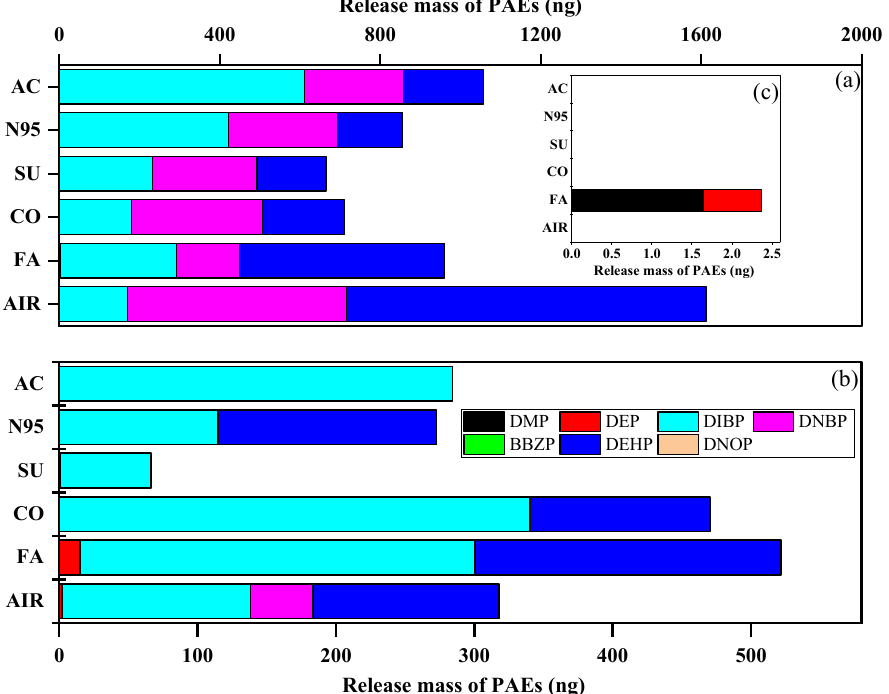
Figure 4. Average 24 h collected mass of each targeted compound of activated-carbon mask sample (AC), N95 mask sample (N95), surgical mask sample (SU), cotton mask sample (CO), fashion mask sample (FA), and blank (AIR) under ( a ) indoors and ( b ) outdoors. ( c ) is the enlarged drawing of DMP and DEP in indoor condition.